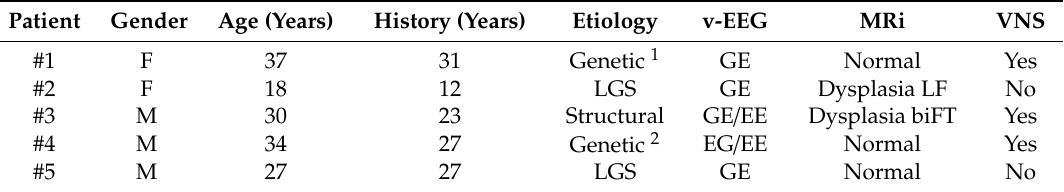
Table 1. Clinical features of the